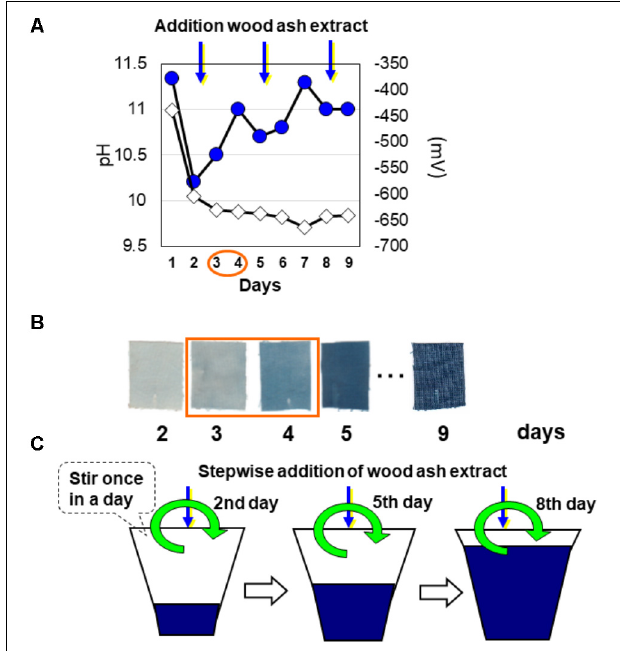
FIGURE 2 | Changes in abiotic parameters in the preparation of indigo fermentation systems and the preparation scheme. The measured parameters were pH (filled circles) and ORP (open diamond) (A) . The textile dyeing intensity (B) was estimated by dipping a strip of textile. Scheme of preparation for initiation via stepwise addition of wood ash extract (C) to the fermentation liquor used for indigo dyeing during the initial incubation period. The indigo fermentation batch was prepared in the laboratory. This figure was reproduced from a figure in Aino et al. (2011) with some modifications. This reproduction was permitted by Oxford University